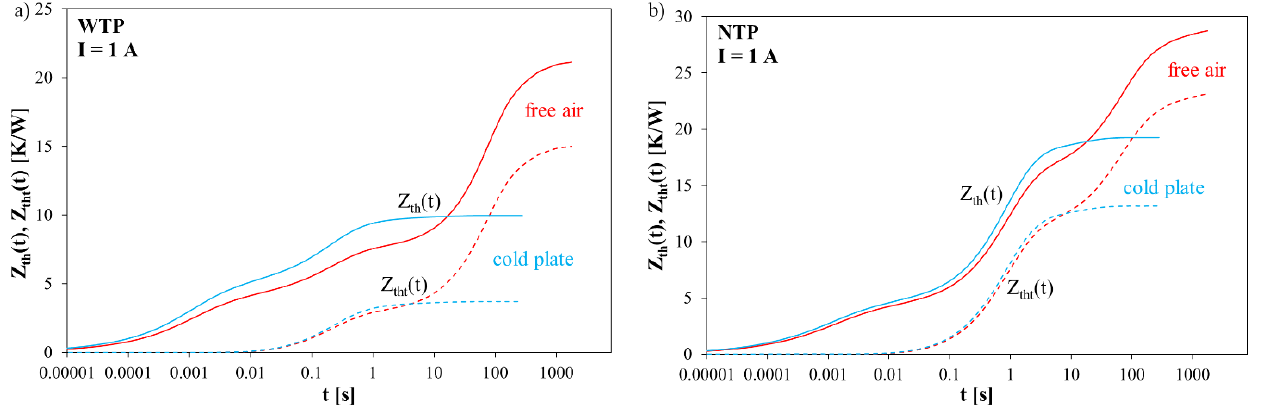
Figure 8. Measured waveforms of self (solid lines) and transfer (dashed lines) transient thermal impedances of the diodes contained in the MCE device WTP ( a ) and NTP ( b ) measured by the T3Ster set-up.